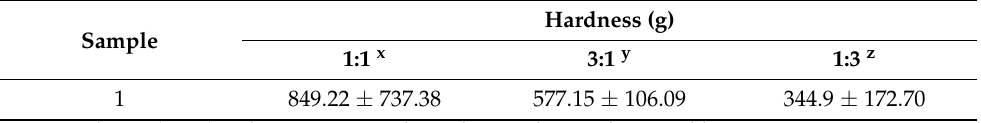
Table 7. The changes of texture parameters according to different concentrations of grape seed